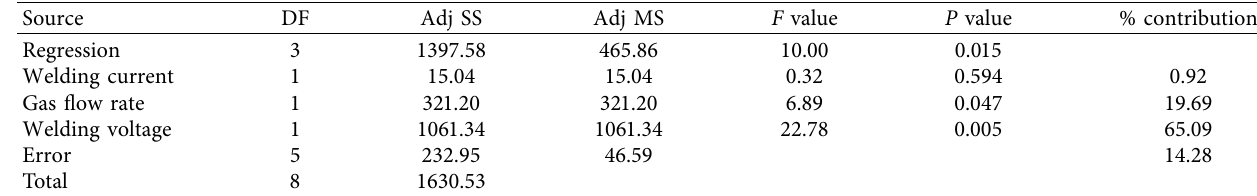
Figure 10: Main effects plot for means. Table 6: Analysis of variance for tensile strength.